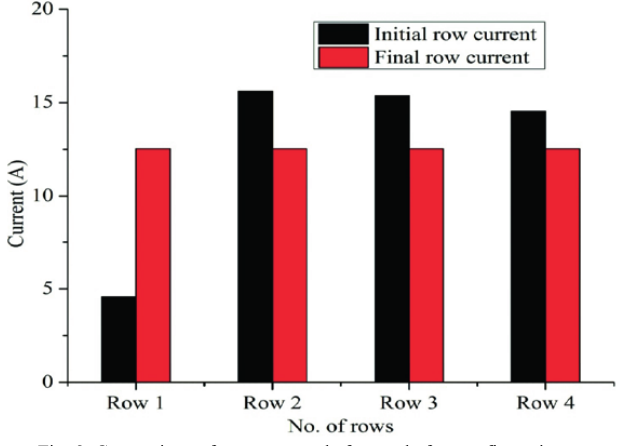
Fig. 8. Comparison of row currents before and after configuration.